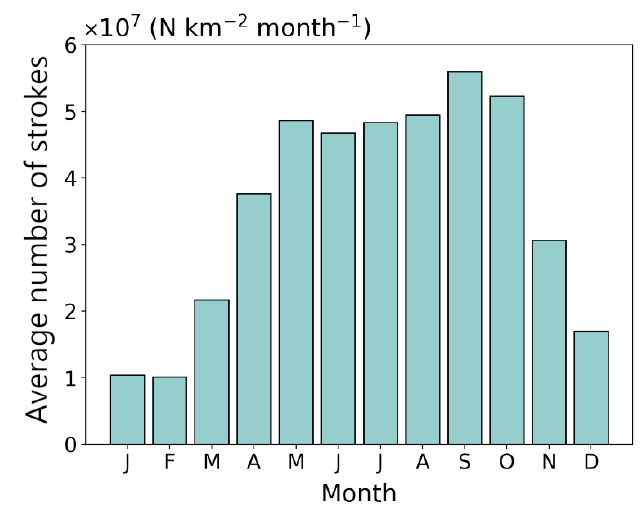
Figure 2. Average monthly distribution of lightning activity (total number N of strokes km −2 month −1 ) over the Extended Central America region for 2012–2020. Data from the World Wide Lightning Location Network (WWLLN).